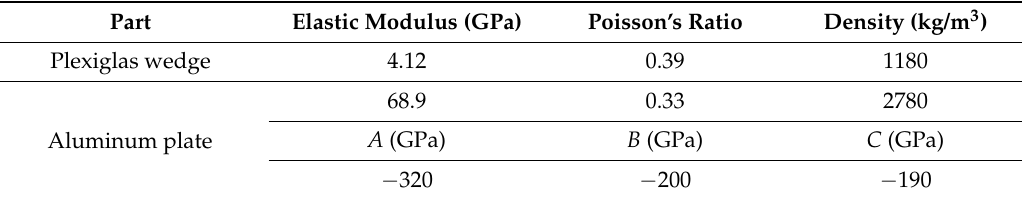
Table 2. Parameters for the mode pairs.